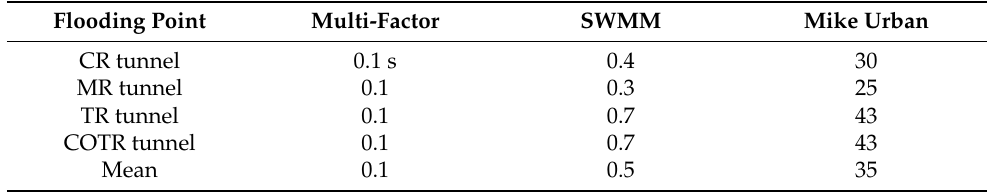
Table 7. The Waterlogging simulation timetable of rainstorm events with each model on 22 May 2020 by the CR tunnel (a), MR tunnel (b), TR tunnel (c), and COTR tunnel (d). Flooding Point Multi-Factor